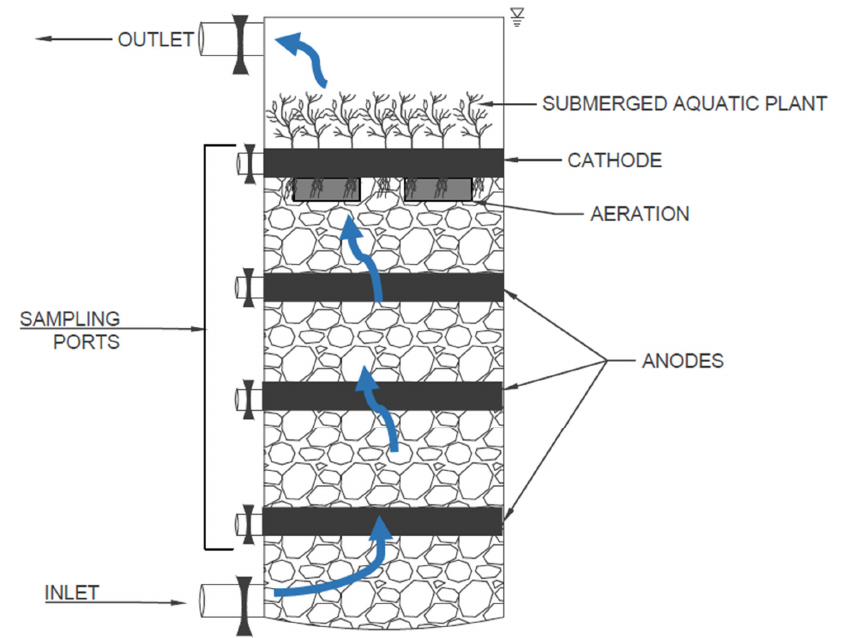
Figure 5. Representation of the up ‐ flow CW ‐ MFC system with supplemental aeration ( adapted from Oon et al., 2017 [55]).